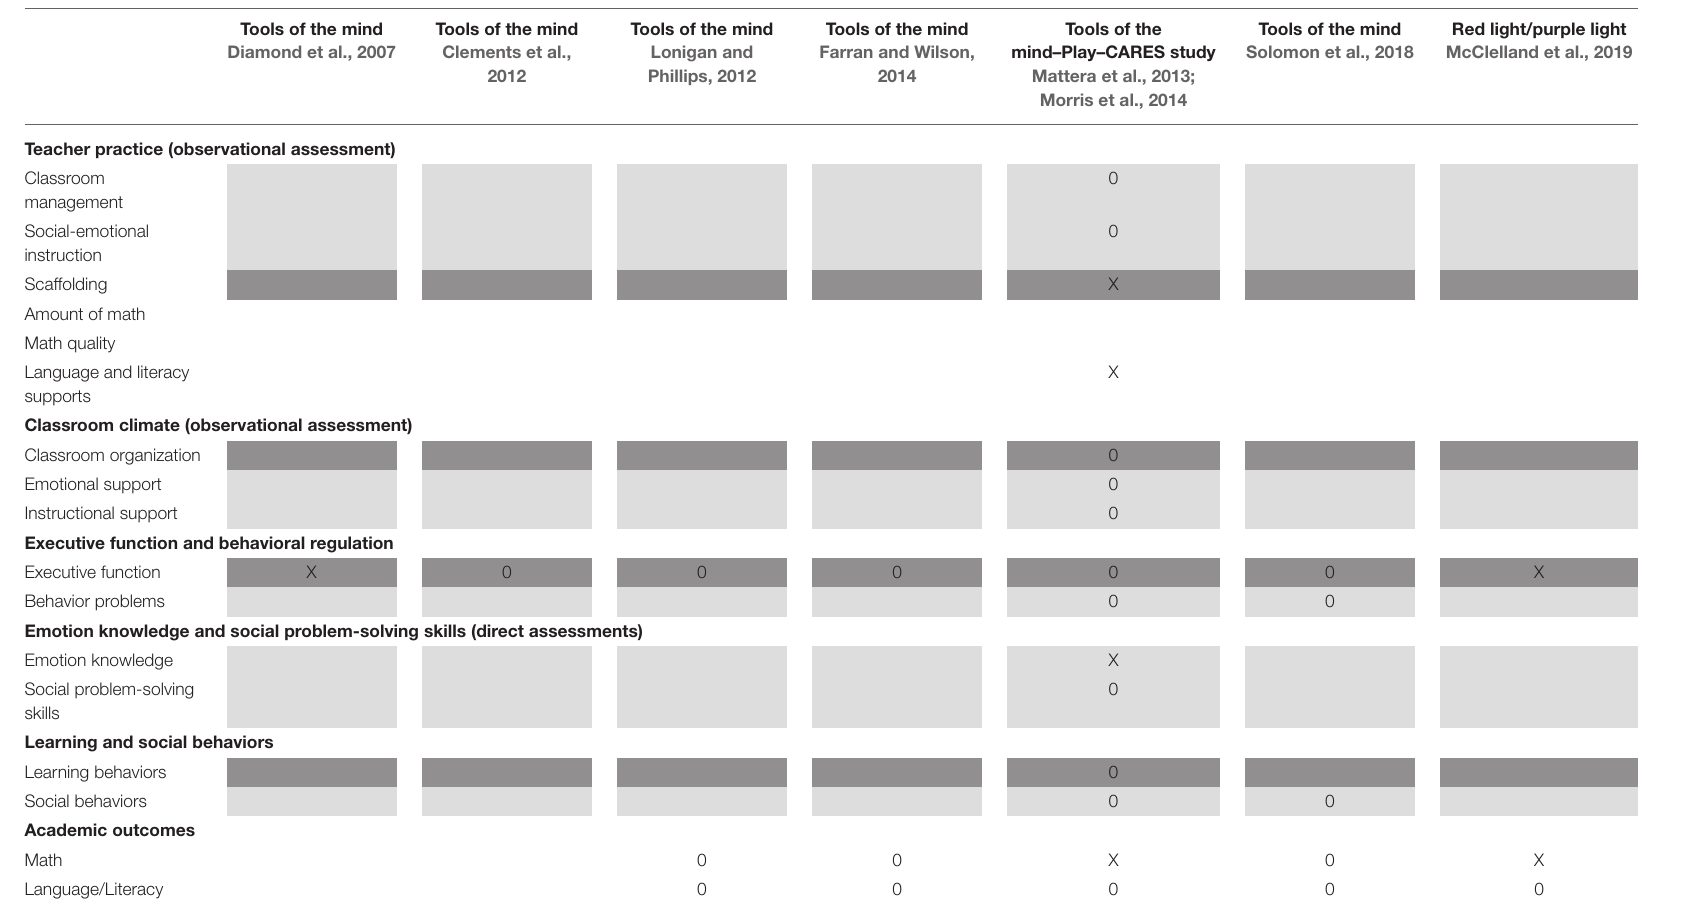
Tools of the mind Diamond et al., 2007